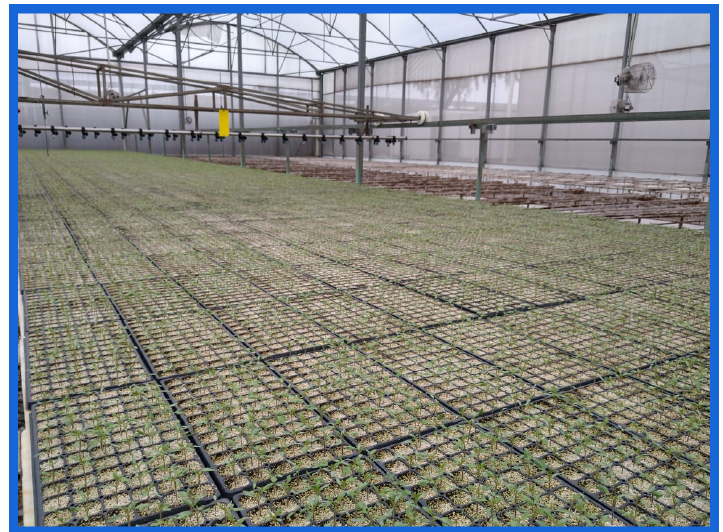
Figure 5. Greenhouse with Portos tomato